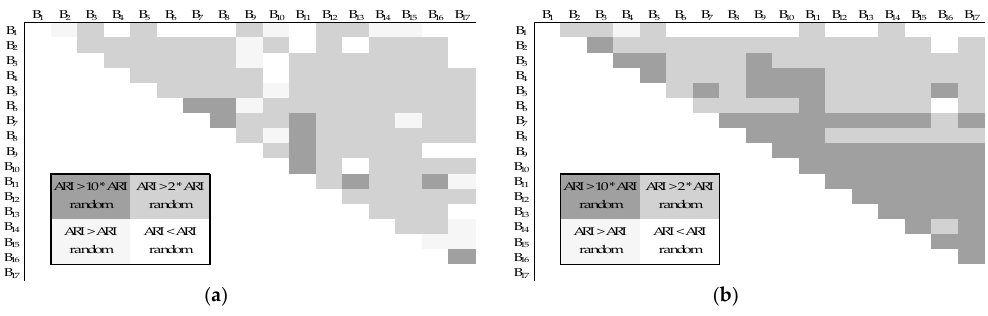
Figure A4. ARI results for 𝑚𝑖𝑛𝑆𝑒𝑟𝑖𝑒𝑠 set at 1% and window length 𝑤 set at 30 days (the short-term version is presented on the left part ( a ) while the long-term version is on the right part of the figure ( b )).